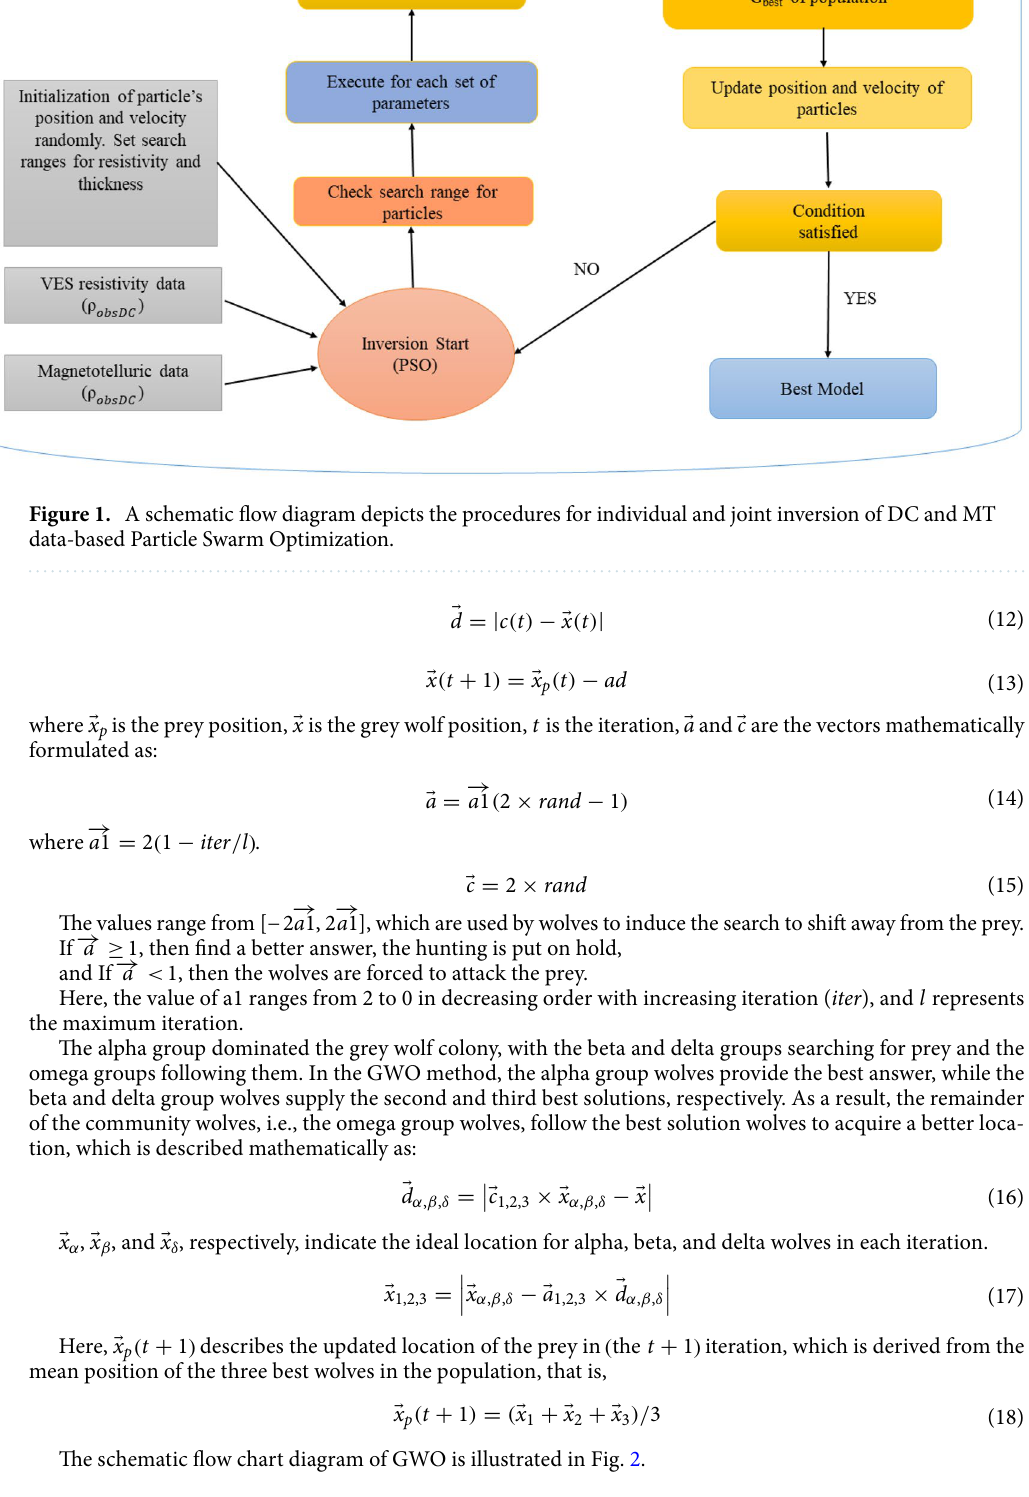
The schematic flow chart diagram of GWO is illustrated in Fig. 2. Variable particle swarm–grey wolf optimizer. Variable Particle Swarm–Grey Wolf Optimizer (vPSOGWO) is a low-level mixed co-evolutionary approach because the functions of both algorithms PSO and GWO are com- bined to offer the final solution 23 . This hybrid algorithm balances GWO’s exploitation and PSO’s exploration capabilities. The position of the alpha ( α ), beta ( β ), and delta ( δ ) wolves of the GWO algorithm that encircle the